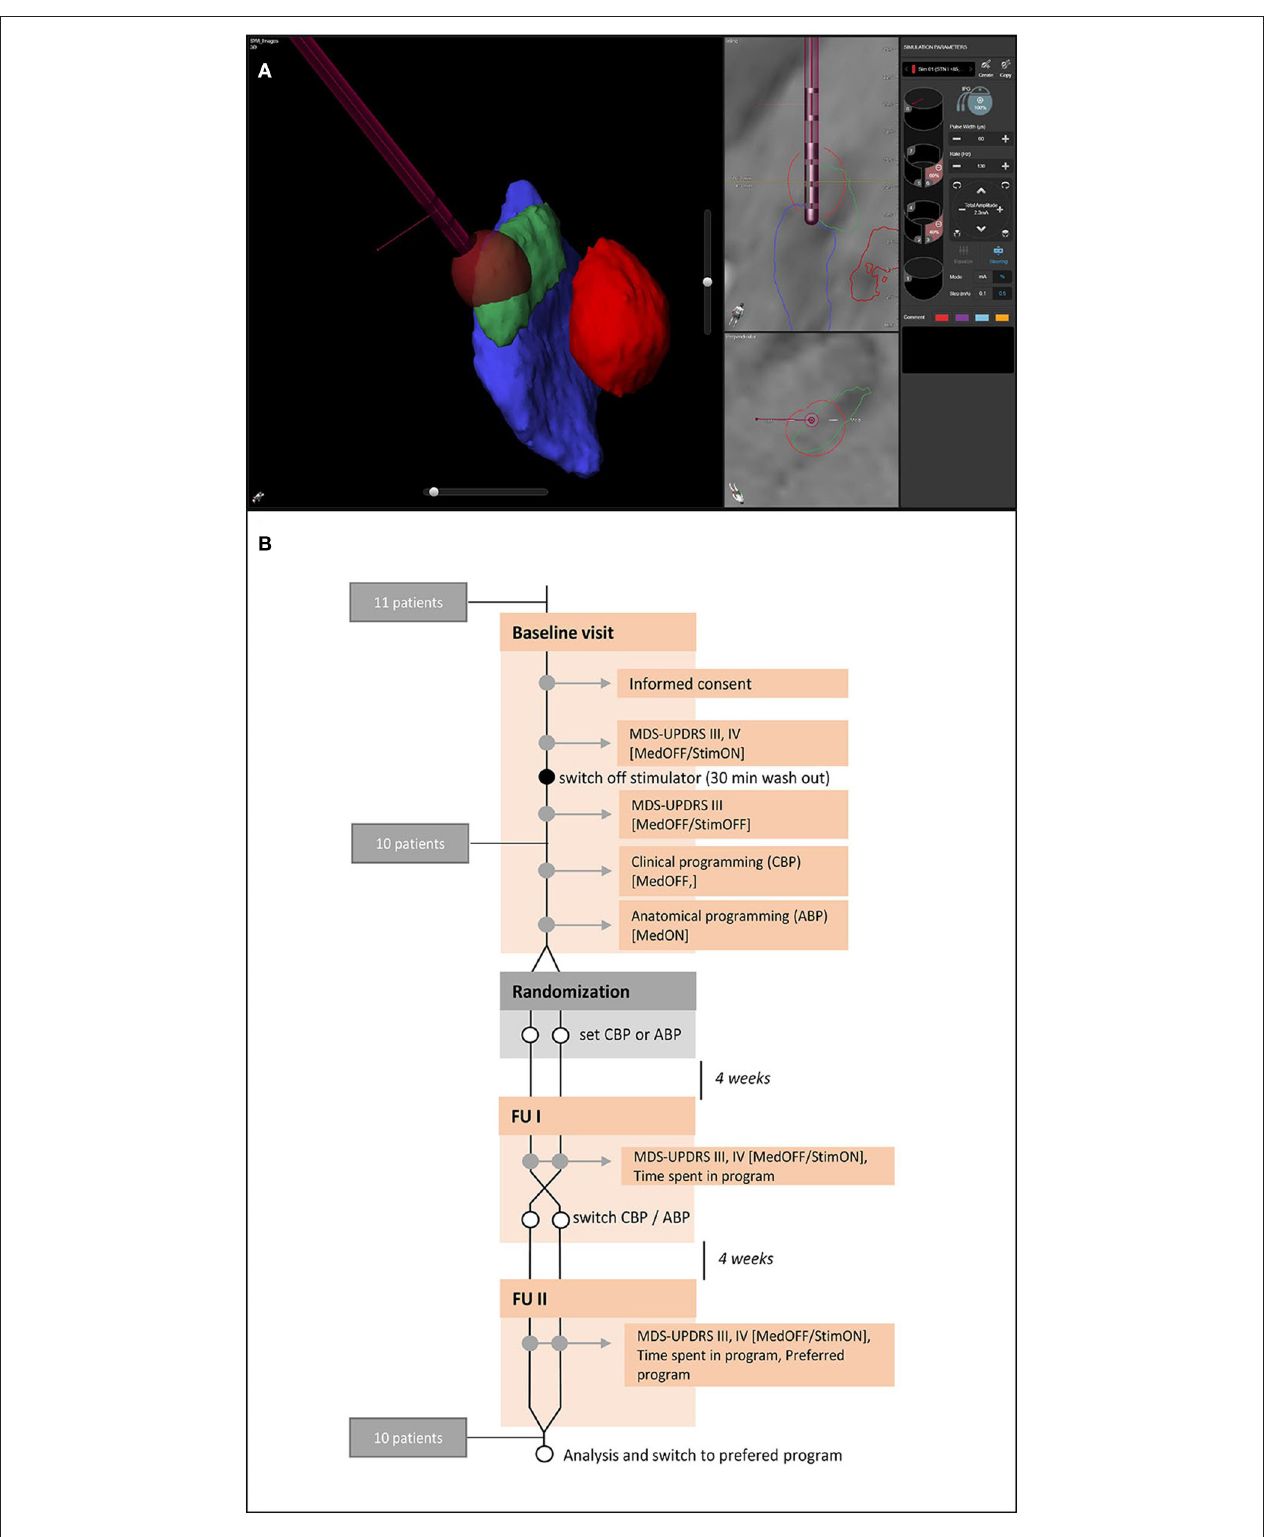
FIGURE 1 | Anatomical visualization and study protocol. (A) Example of a visualization of the relevant nuclear structures (red, red nucleus; green, subthalamic nucleus, blue, substantia nigra) and the deep brain stimulation electrode with GuideXT. (B) Study protocol.